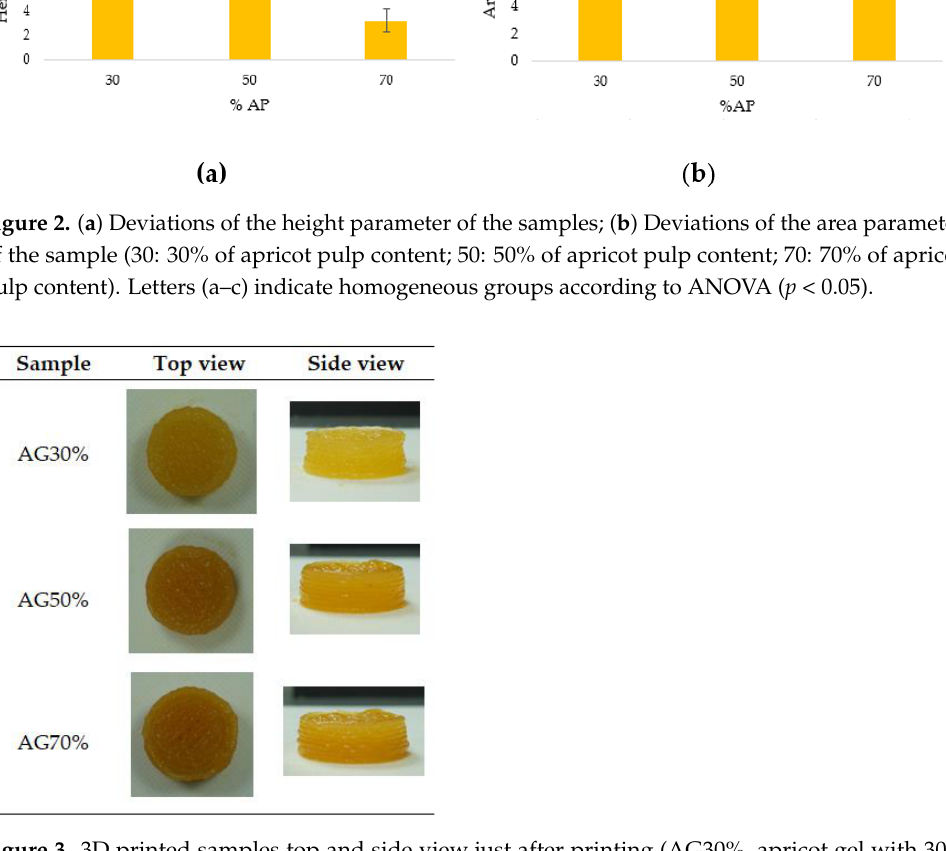
Figure 3. 3D printed samples top and side view just after printing (AG30%, apricot gel with 30% of apricot pulp; AG50%, apricot gel with 50% of apricot pulp; AG70%, apricot gel with 70% of apricot